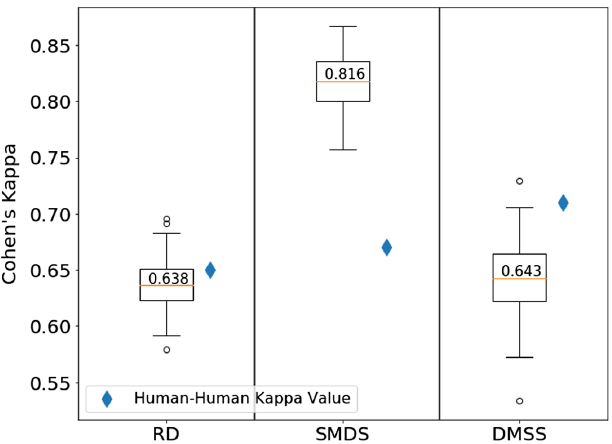
FIG. 8. Comparison of interrater reliability of the machine learning system and a human rater. Cohen ’ s kappa value ranges are shown comparing the machine learning system to the human categorization. Diamonds represent the kappa values between the original human categorization and a different human categori- zation. Generally, the machine learning system achieved the same level of agreement with the original human rater as the other